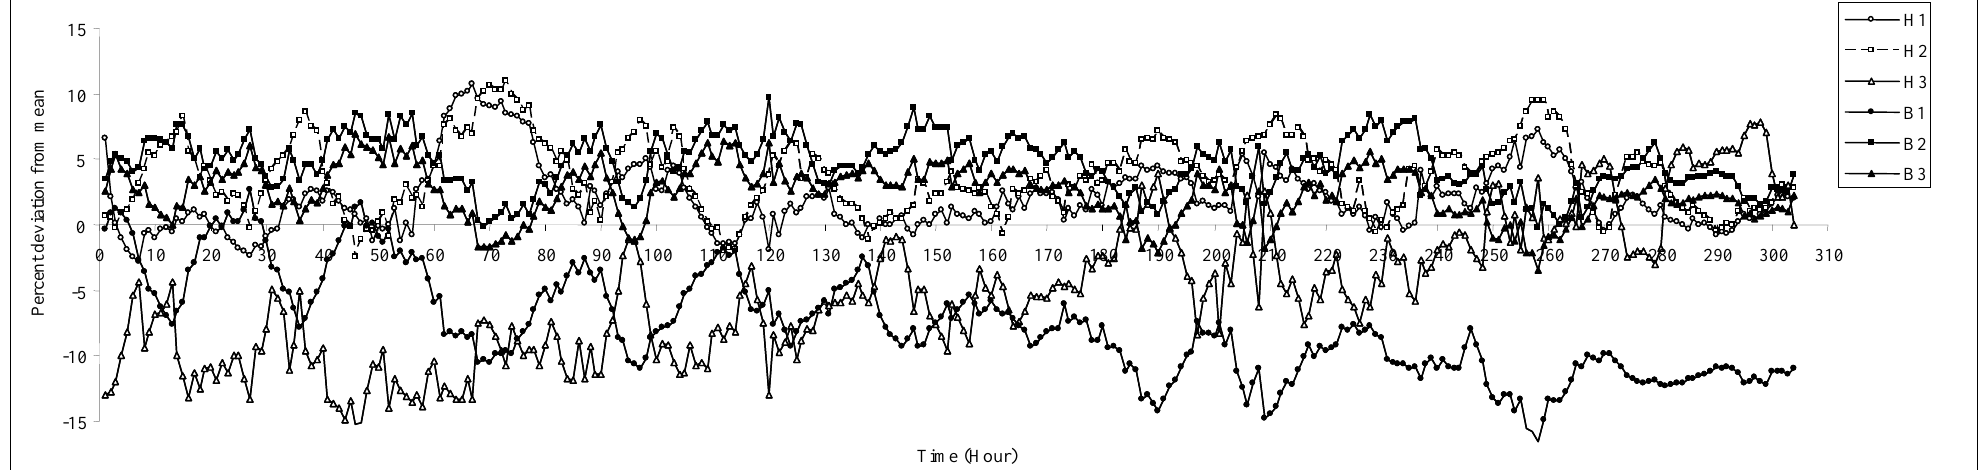
data measured concurrently by 6 sensor 2